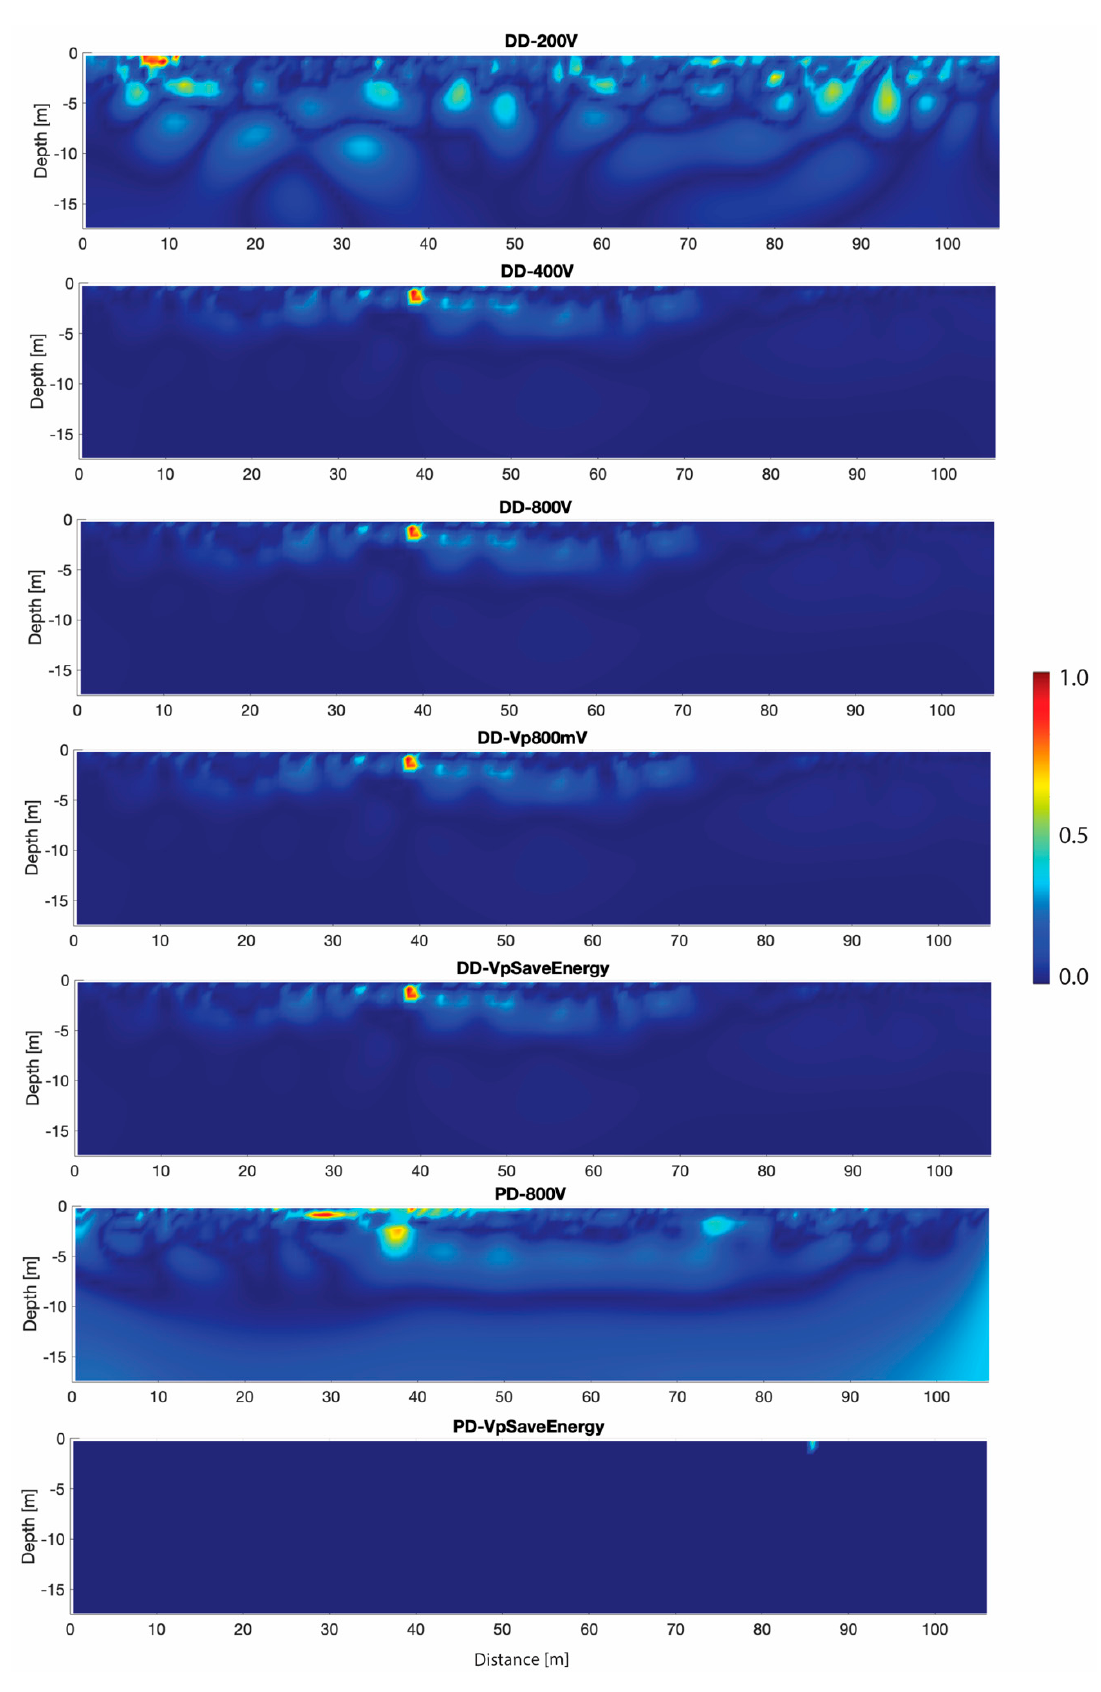
Figure 8. Normalized ERT-error ( δ ERT norm ), for each input voltage, of the mean simulated dataset.